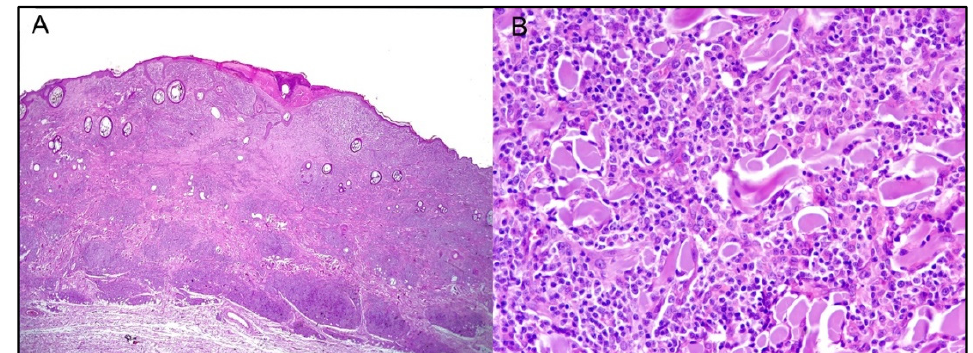
Figure 5. Canine cutaneous histiocytoma, hematoxylin, and eosin: ( A ) the dermis is expanded by a dome-shaped densely cellular neoplasm, characterized at the base by a densely basophilic area suggestive of lymphocyte infiltration. ( B ) The neoplasm is composed of round histiocytic cells to which numerous lymphocytes are mixed, that are responsible for tumor regression, 20 ×